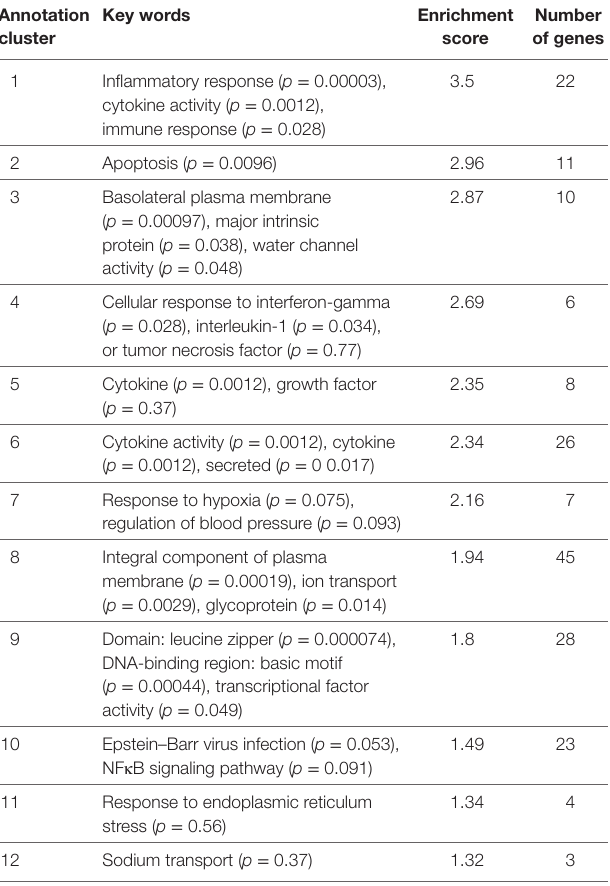
TaBle 2 | The 12 significantly enriched annotation clusters identified with DAVID 6.8 in the 91 differentially expressed genes of the acute and subacute model.